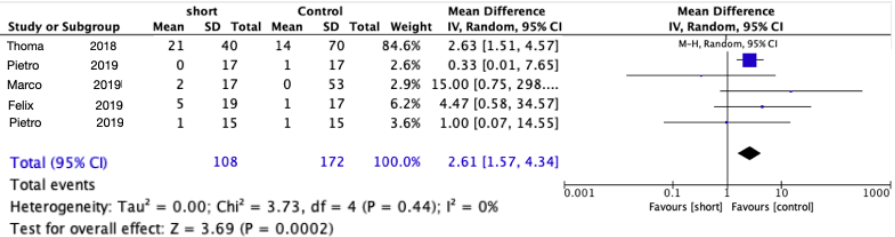
Figure 3. Comparison of biological complications using short implants vs. longer implants with el- evation of the sinus floor after 5 years in function via a meta -analysis.